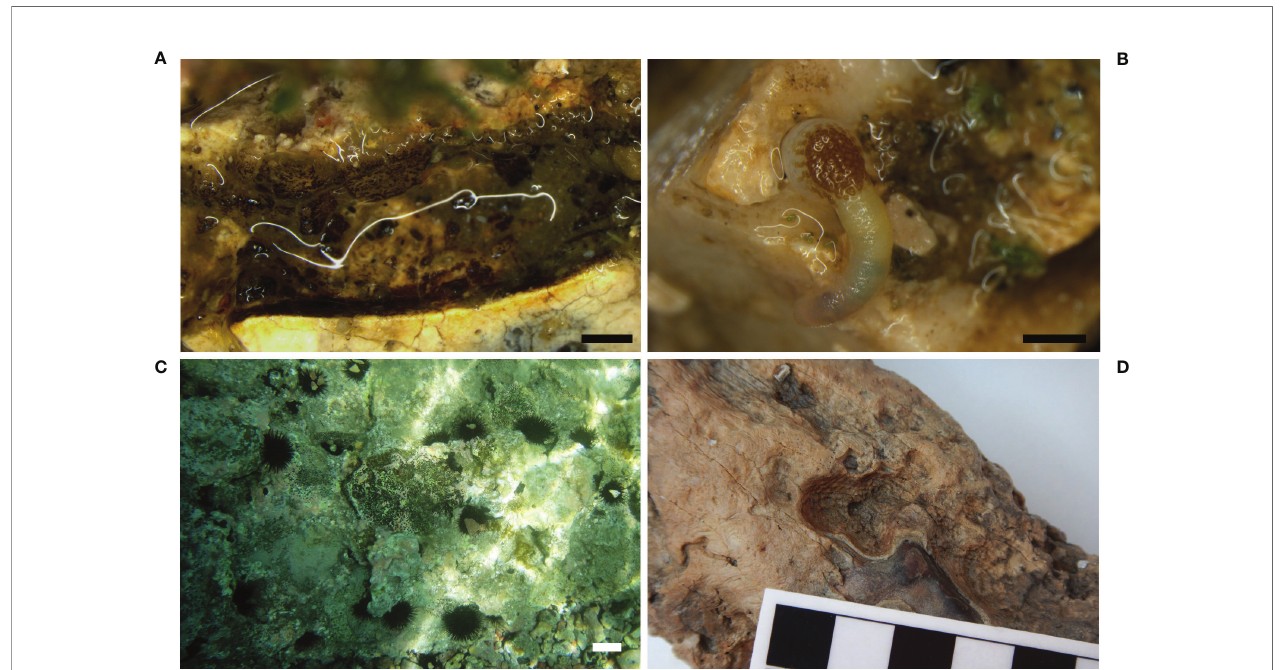
FIGURE 9 | Sipunculids and echinoids. (A) Tunnel produced by the sipunculid Aspidosiphon muelleri in the bedding mortar of a mosaic fl oor in the Underwater Archaeological Park of Baiae (stereomicroscope photo); (B) specimen of A . muelleri inside an erratic tessera of a mosaic fl oor in the area of Portus Julius , Baiae (stereomicroscope photo); (C) sea urchins on architectural elements of the submerged Villa of the dolia , Epidaurus (underwater photo); (D) bioerosion traces attributed to sea urchins on an ivory tusk recovered from the Bajo de la Campana shipwreck, Cartagena. Scale bars: (A, B) = 1 mm; (C) = 5